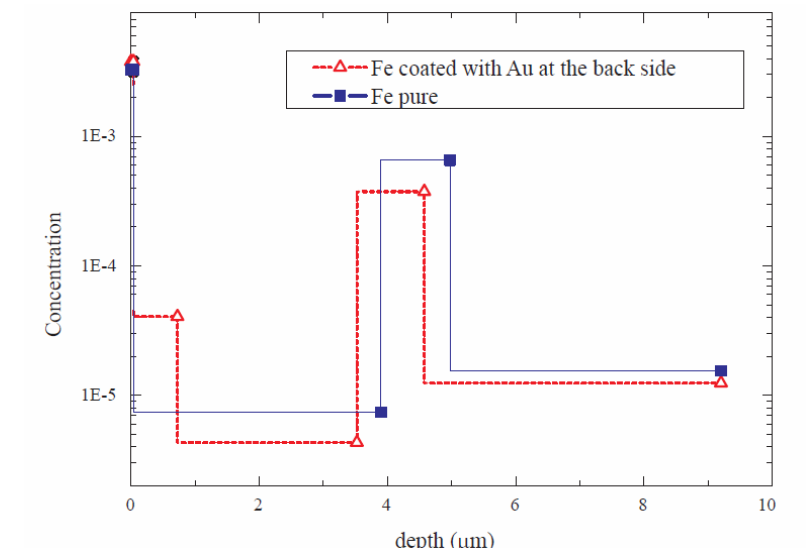
Figure 2 – Deuterium depth profile for the Fe samples annealed in vacuum at 873 K for 1h and then exposed to deuterium plasma at 300 K to a fluence of F = 6×10 24 Dm